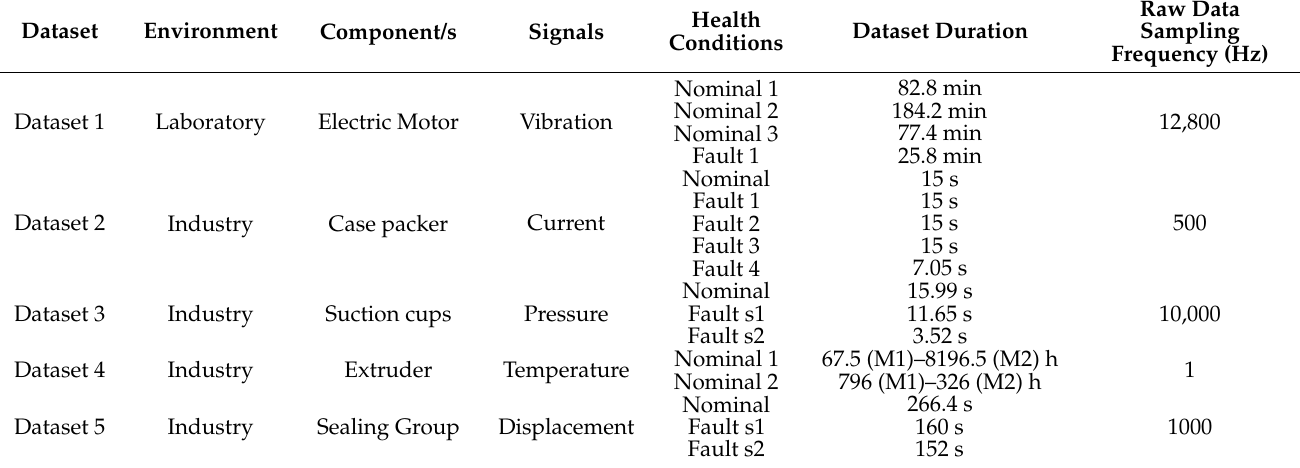
Table 1. Description of the available